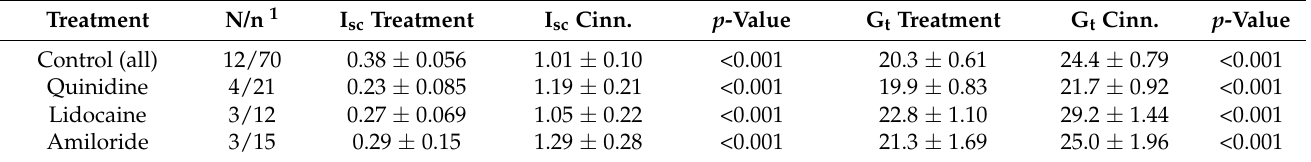
Table 2. Cinnamaldehyde response in the colonic tissue from young pigs (controlled in-house study). The tissues were pretreated as indicated in the first column, yielding the values “I sc treatment” ( µ eq · cm − 2 · h − 1 ) and “G t treatment” (mS · cm − 2 ) from Table 1. Subsequently, 1 mmol · L − 1 cinnamaldehyde was added. The columns “I sc cinn.” ( µ eq · cm − 2 · h − 1 ) and “G t cinn.” (mS · cm − 2 ) designate the peak value of the responses within a 15 min interval after the application of